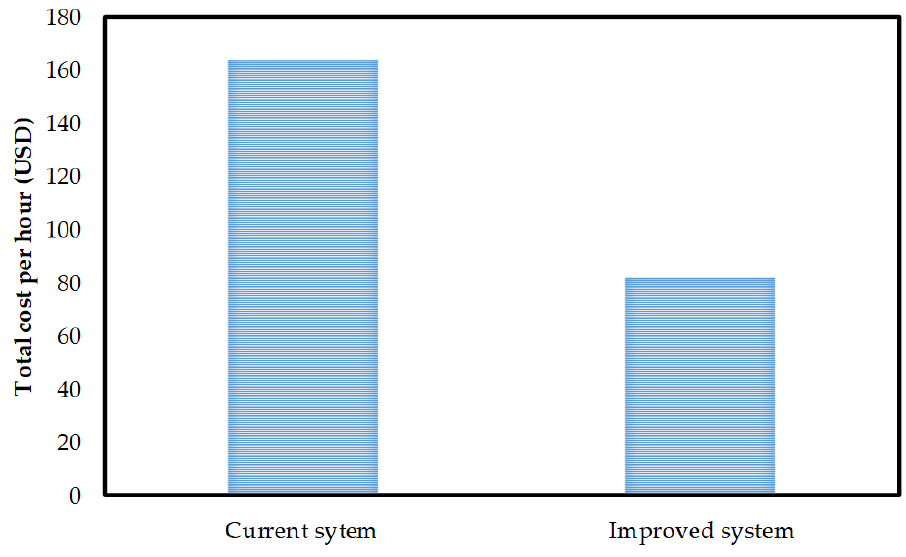
Figure 6. Comparison between the current system and the improved system.